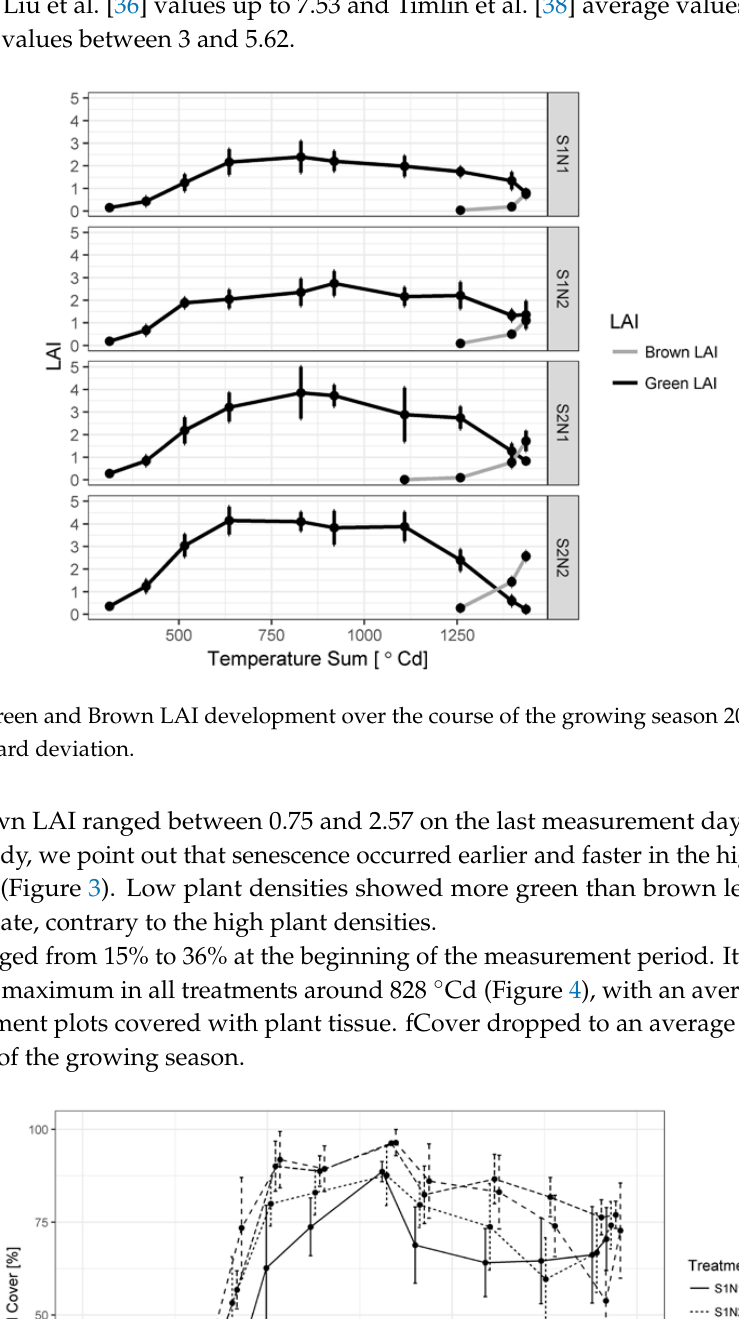
Figure 4. Fractional cover development over the course of the growing season 2016. Error bars show standard deviation. The horizontal position was adjusted to avoid overlap.